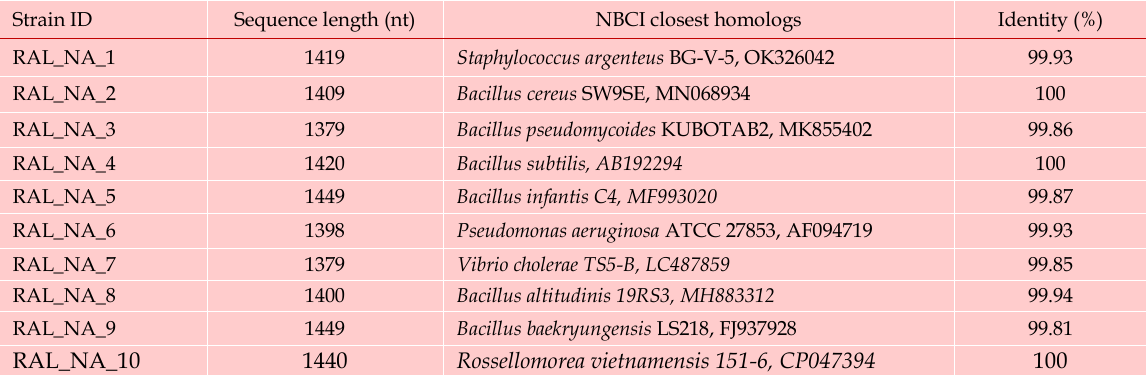
The closest 16S rRNA sequences of the isolated strains obtained in NCBI